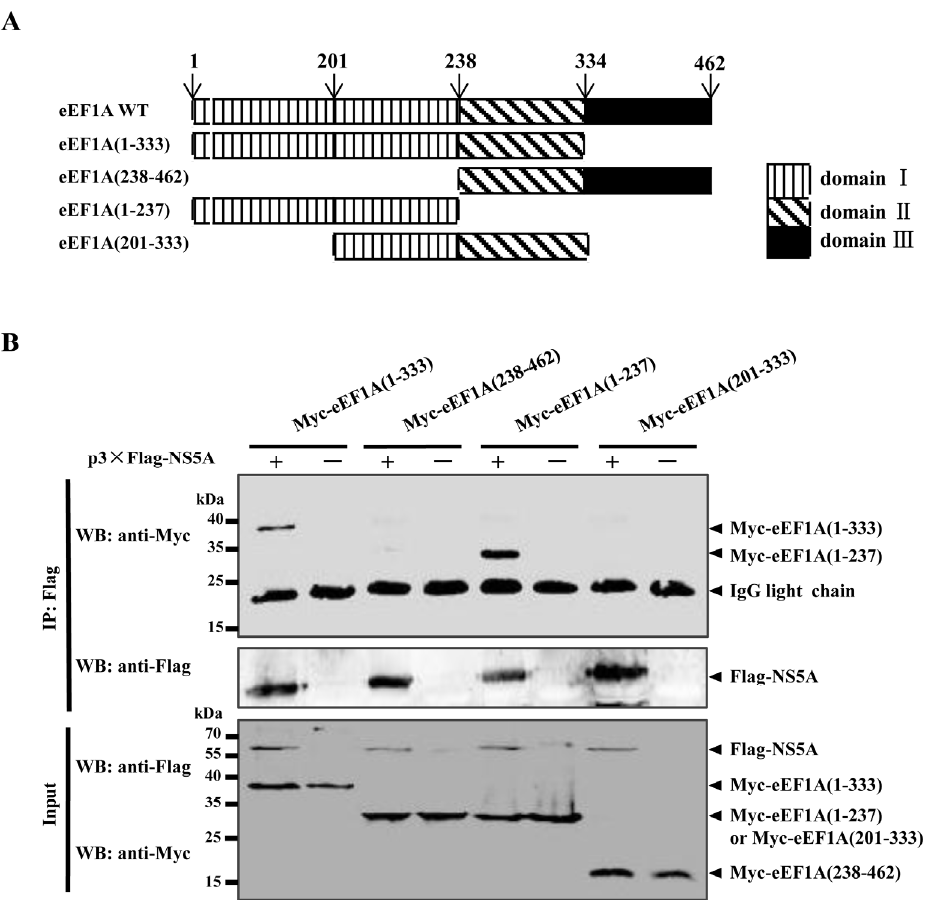
Figure 2. The domain I of eEF1A is required for its association with NS5A. ( A )